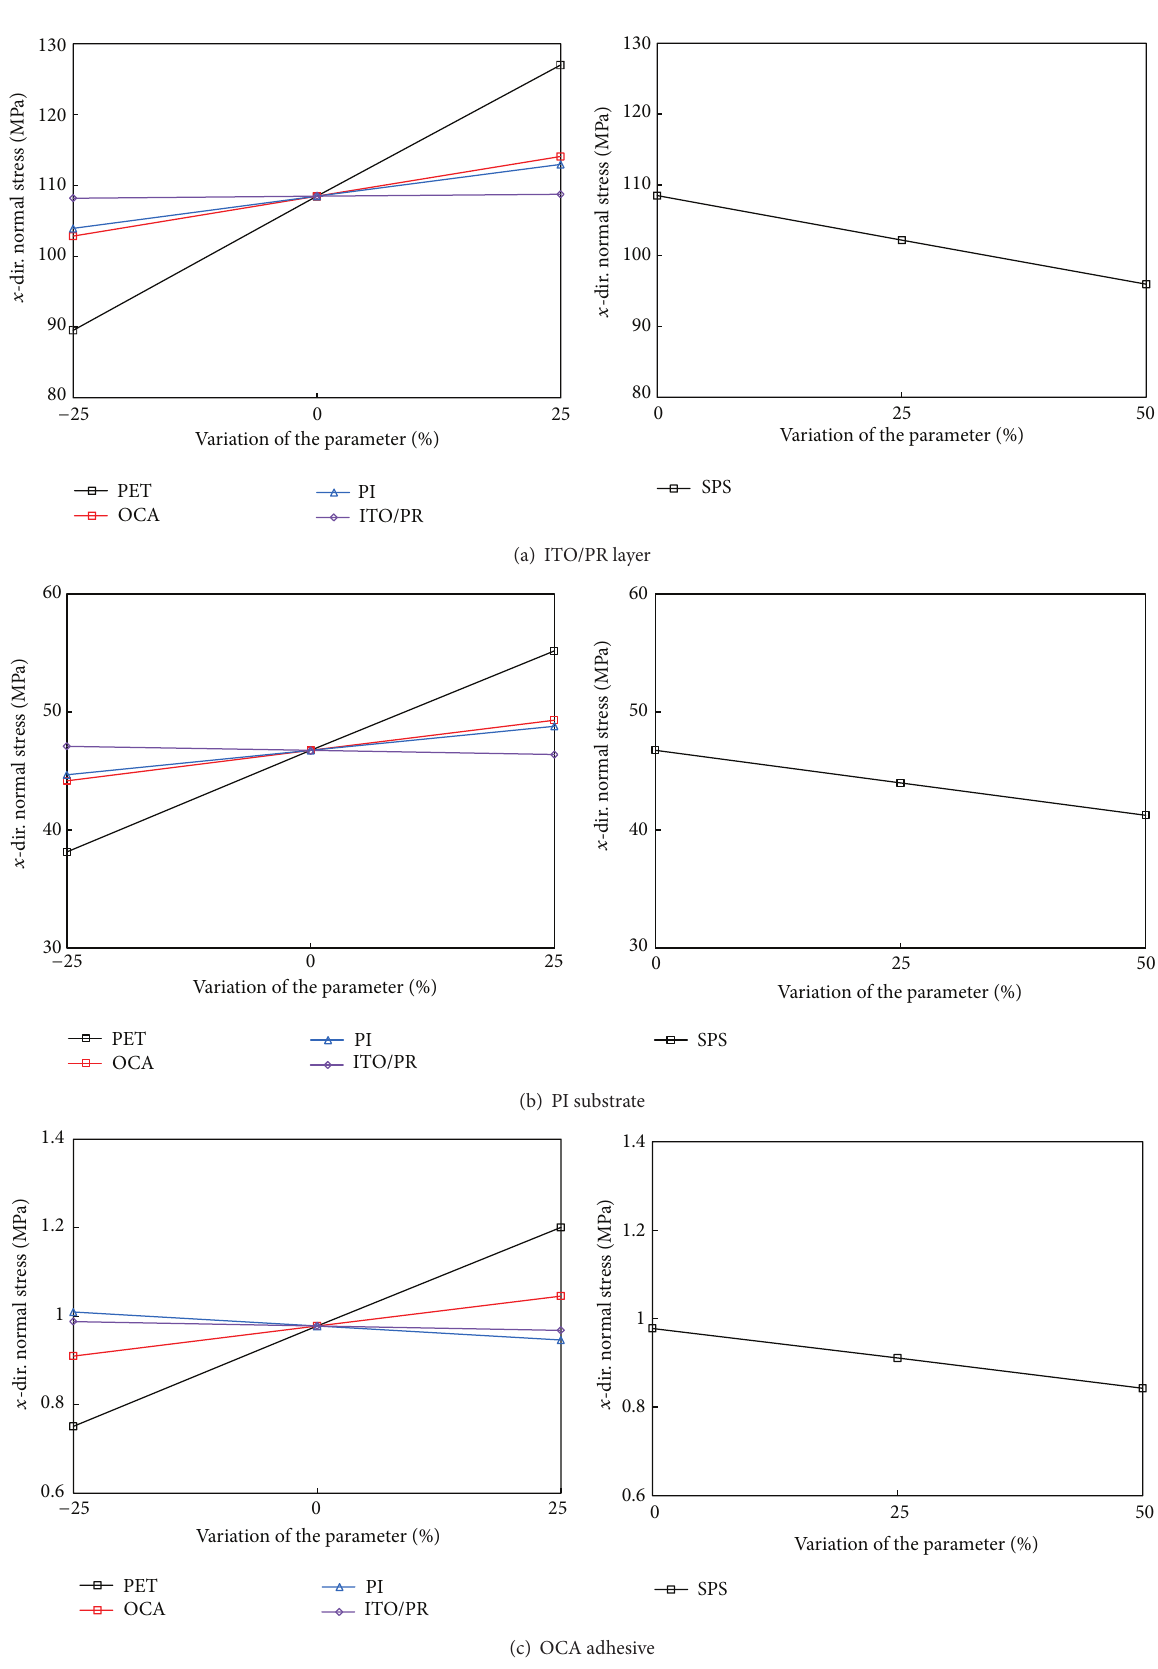
Figure 13: Effects of the thickness of the components on the bending